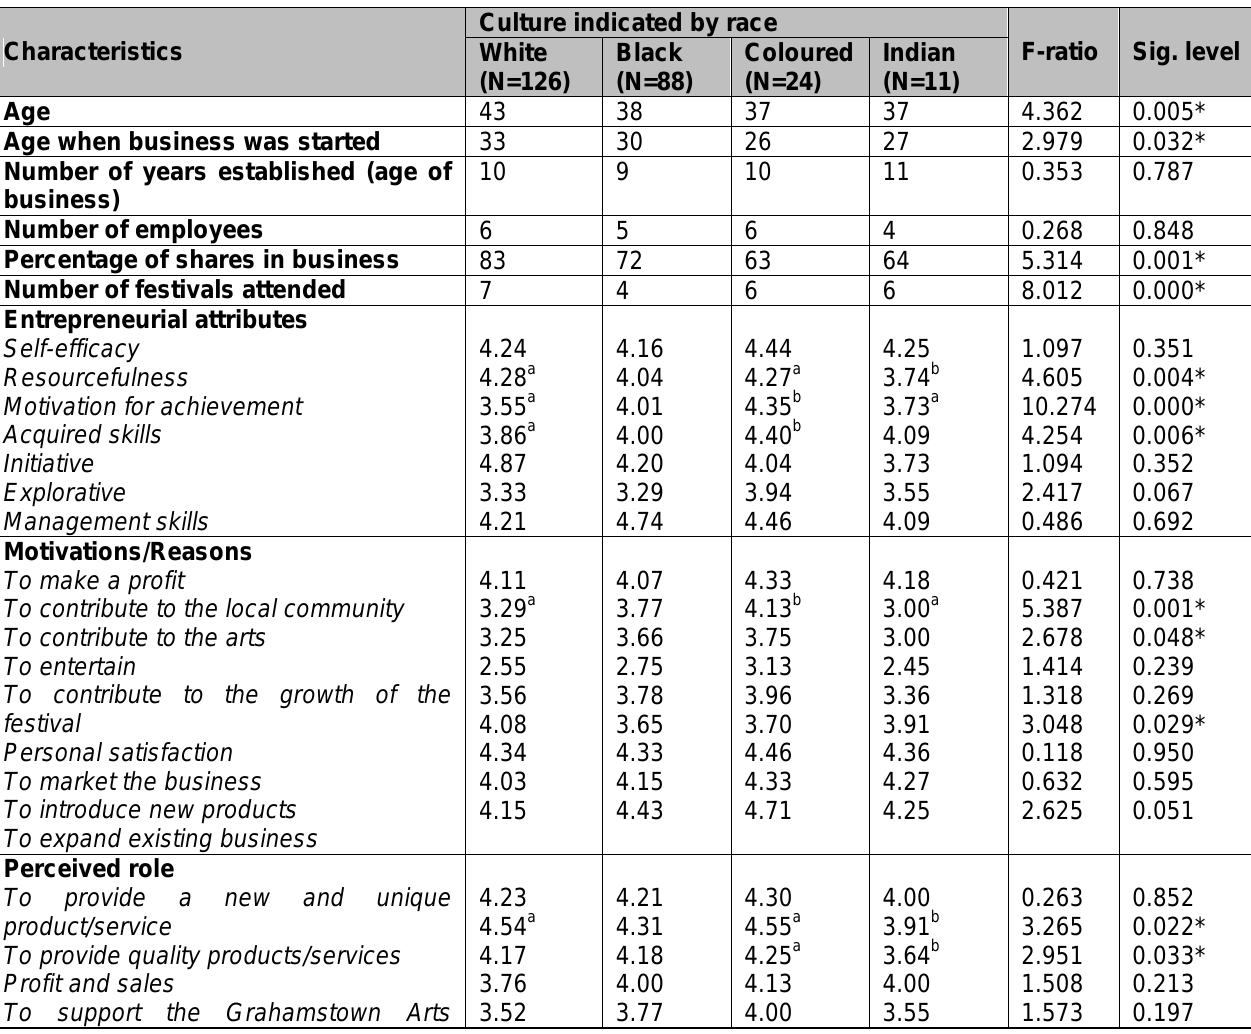
Table 5: Results of ANOVA and Tukey’s post hoc multiple comparisons for visitor characteristics between different cultures